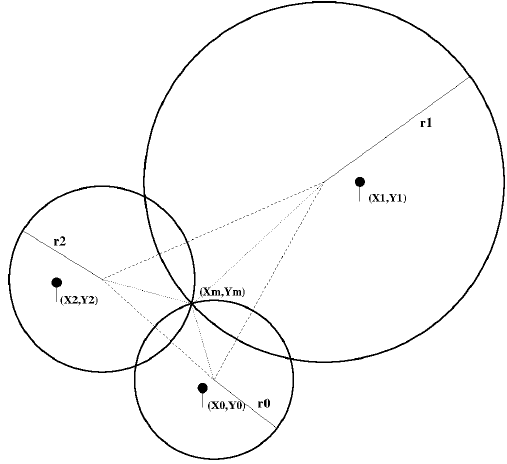
Figure 3. Ideal solution to a tri-lateration